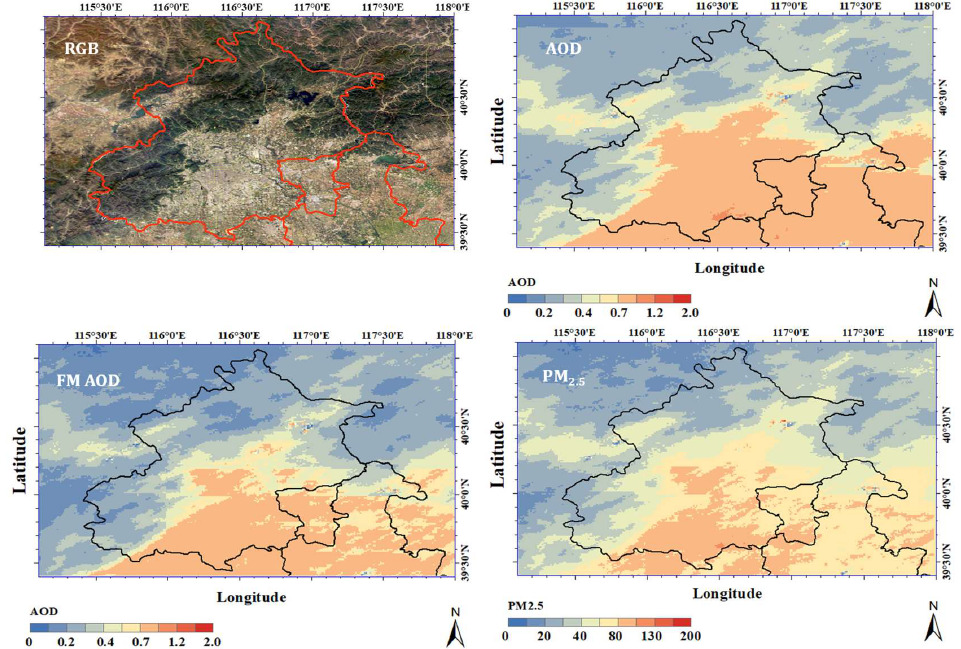
Figure 16. The annually averaged MODIS Multi-Angle Implementation of Atmospheric Correction MAIAC AOD, MODIS fine mode (FM) AOD, and SPSEMCA retrieved PM 2.5 , of the Beijing area in